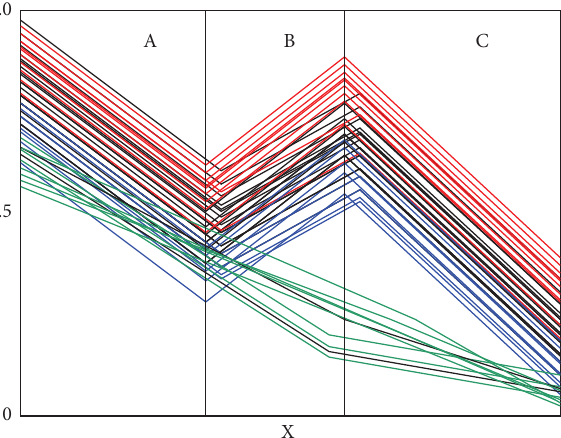
Figure 9: Graph of clustering results.